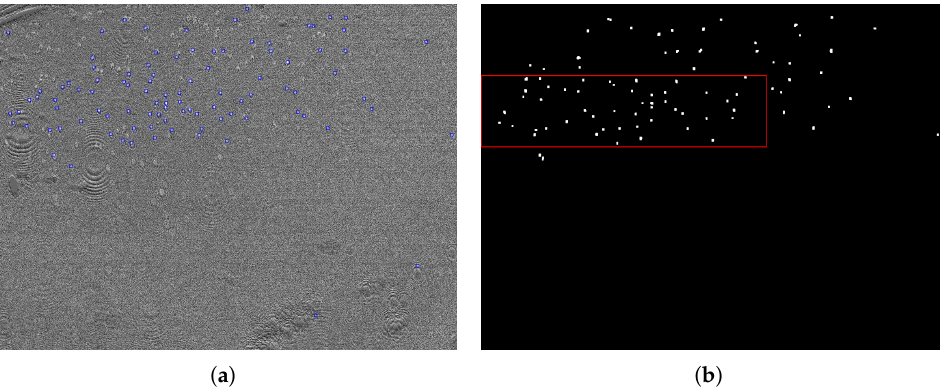
Figure 11. ( a ) example of a preprocessed image showing single-image particle detections for a sample containing 300nm polystyrene particles as blue boxes, and ( b ) the corresponding merged map I (merge) showing the merged traces calculated on the whole set of preprocessed images. The determined focus region is marked by a red